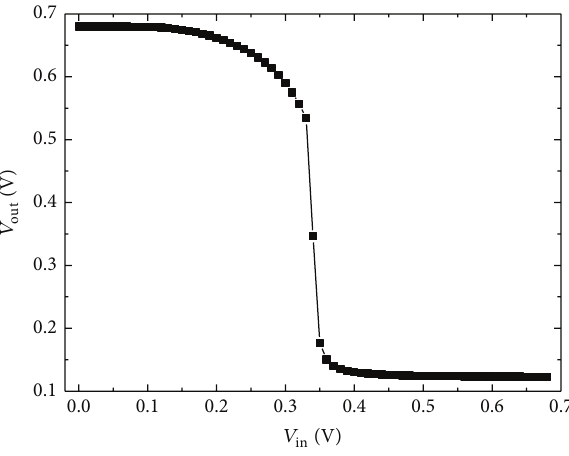
Figure 7: DC simulated inverter transfer curve.